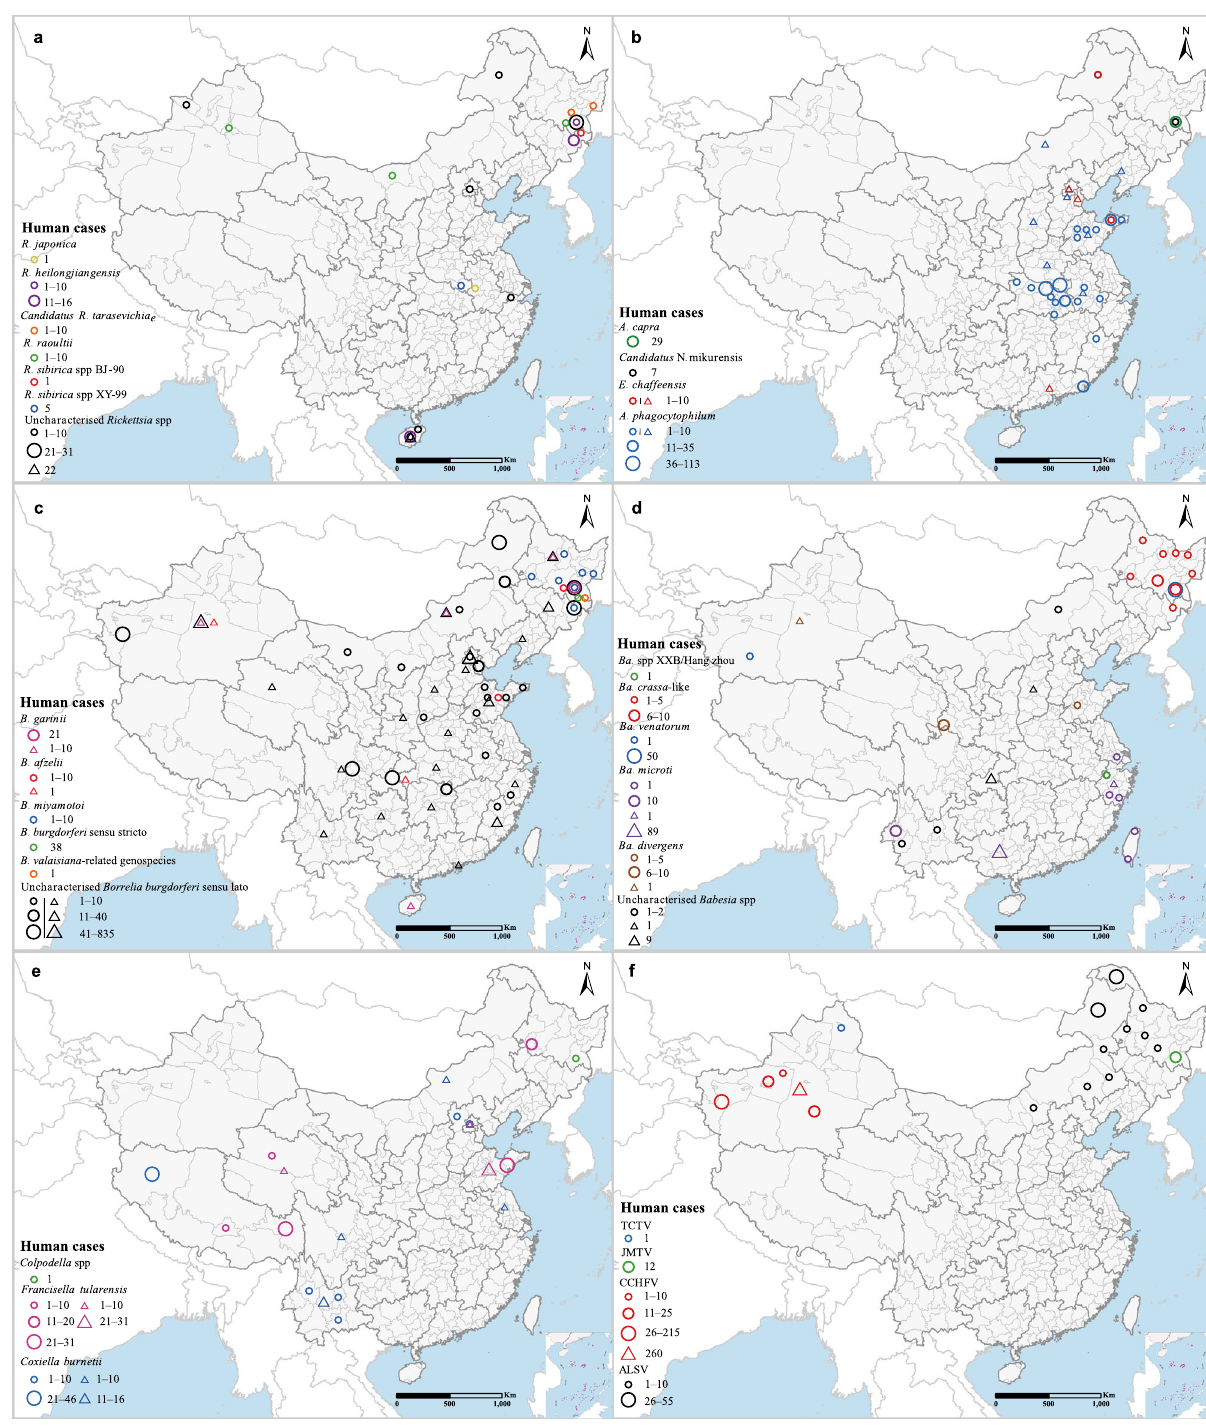
Fig. 4 The distributions of human cases by species of tick-borne agents in China during 1950 – 2018. Human cases are positioned at the center of either province (triangles) or prefectures/counties (circles) depending on data availability. a spotted fever group rickettsiae; b Anaplasmataceae ; c Borrelia ; d Babesia spp.; e bacteria; f viruses. Human cases of SFTSV and TBEV are not shown as they are described in other fi gures. Another fi ve tick-borne viruses, including Huangpi tick virus, Lihan tick virus, Wenzhou tick virus, Wuhan tick virus, and Yongjia tick virus, were not displayed in the map due to lack of location information. Source data are provided as a Source Data fi